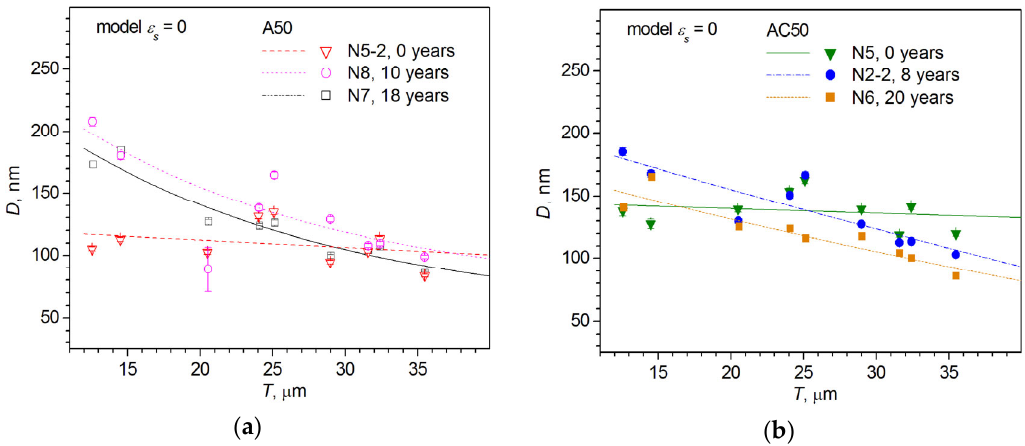
Figure 17. Distribution of the crystallite size D = D hkl 0 estimated in the framework of zero microstrain assumption ( model ε s = 0) in the Al wires along the depth T from the surface of the ( a ) A50 and ( b ) AC50 wires. Sample numbers according to Table 2 and their service lifetimes are shown in ( a , b ). The approximation lines in ( a , b ) are drawn according to the exponential ‐ decay law.